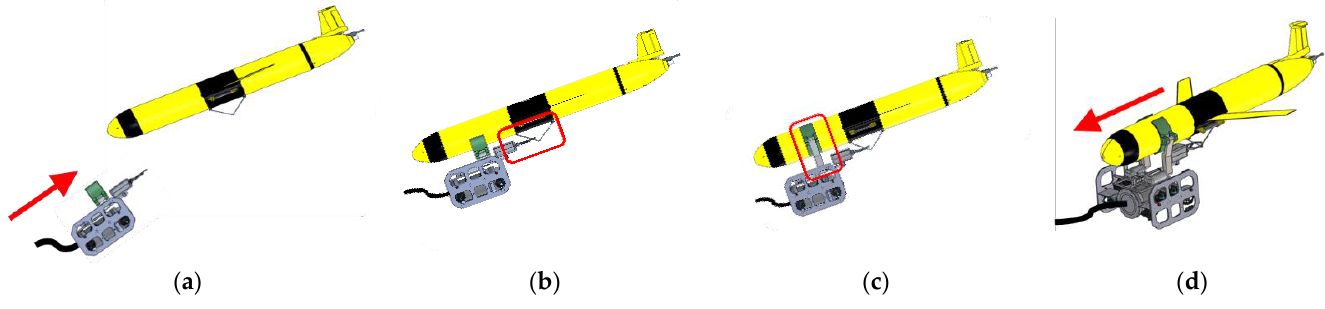
Figure 3. The capturing stage of the proposed process: ( a ) The ROV approaches the glider from below; ( b ) The ROV’s gripper picks up the hook on the glider’s body; ( c ) The ROV’s clamp holds the glider’s body; ( d ) The ROV starts to retrieve the glider back to a mother ship or station. Retrieving stage: The ROV carries the glider back to the mother ship or station.